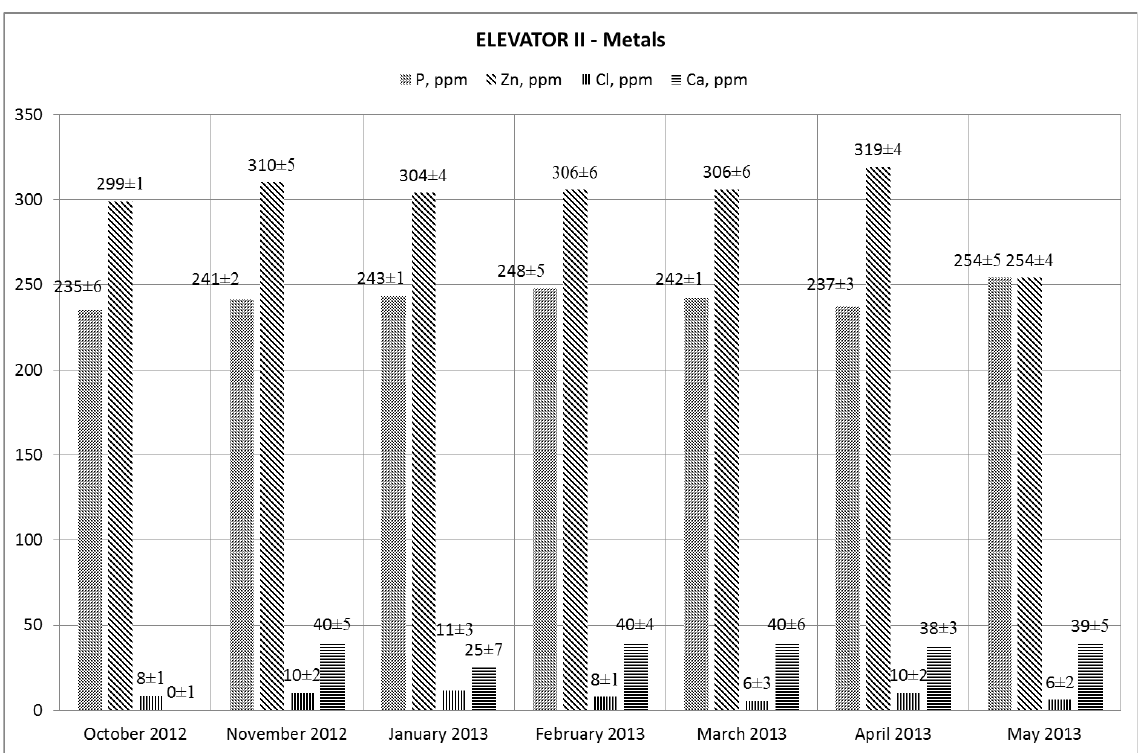
Figure 9. Metals in Elevator II.